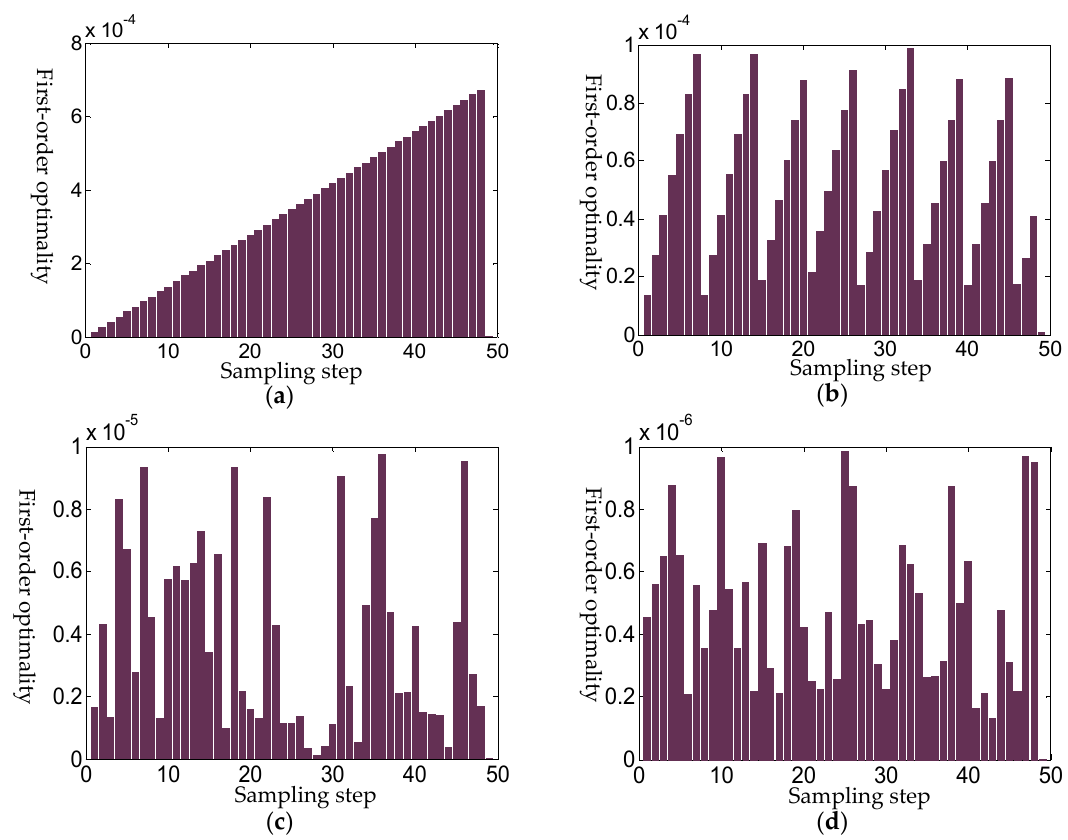
Figure 10. Different cycle of first-order optimality shows with respect to different intermediate iteration termination conditions, with 50 sampling steps. ( a ) Termination condition of 10 − 3 ; ( b ) Termination condition of 10 − 4 ; ( c ) Termination condition of 10 − 5 ; ( d ) Termination condition of 10 − 6 .